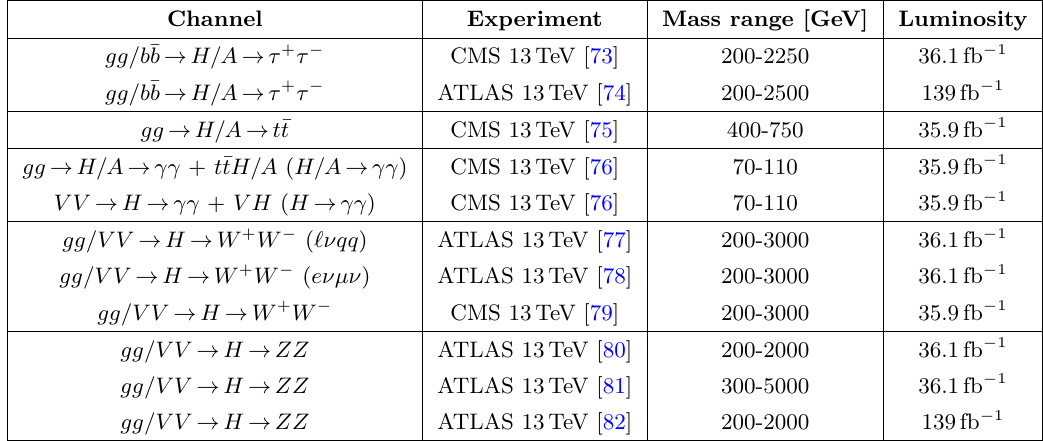
Table 1 . The upper limits at 95% C.L. on the production cross-section times branching ratio of τ + τ − , t ¯ t , γγ , WW , and ZZ considered in the H and A searches at the